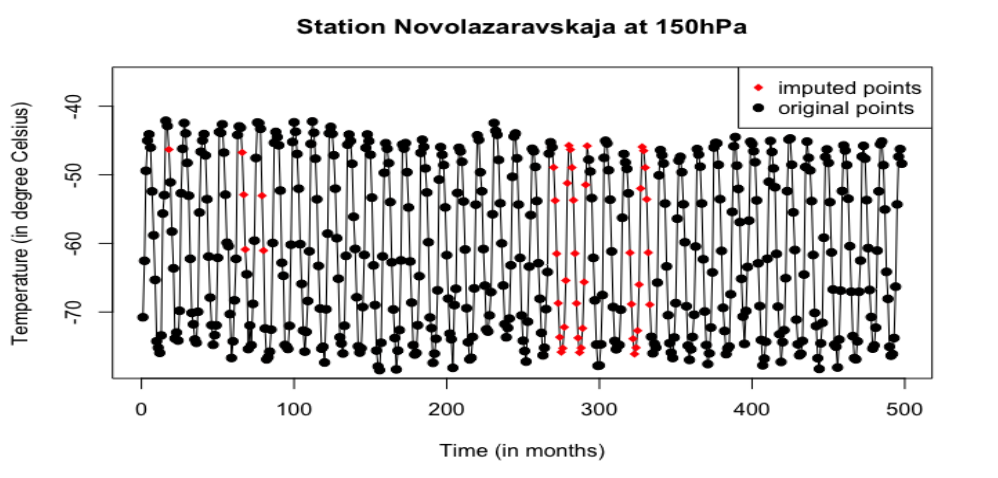
Figure 5. An illustration of the Novolazaravskaja time series at 150 hPa before and after